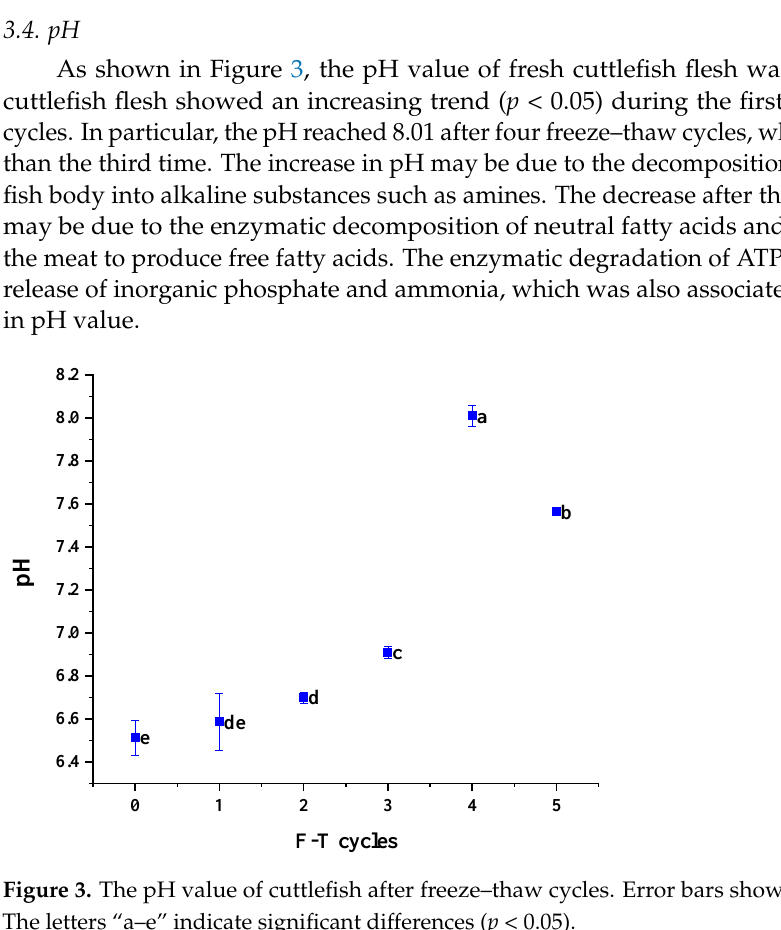
Table 1. Color change of cuttlefish flesh that had undergone repeated freeze–thaw cycles.